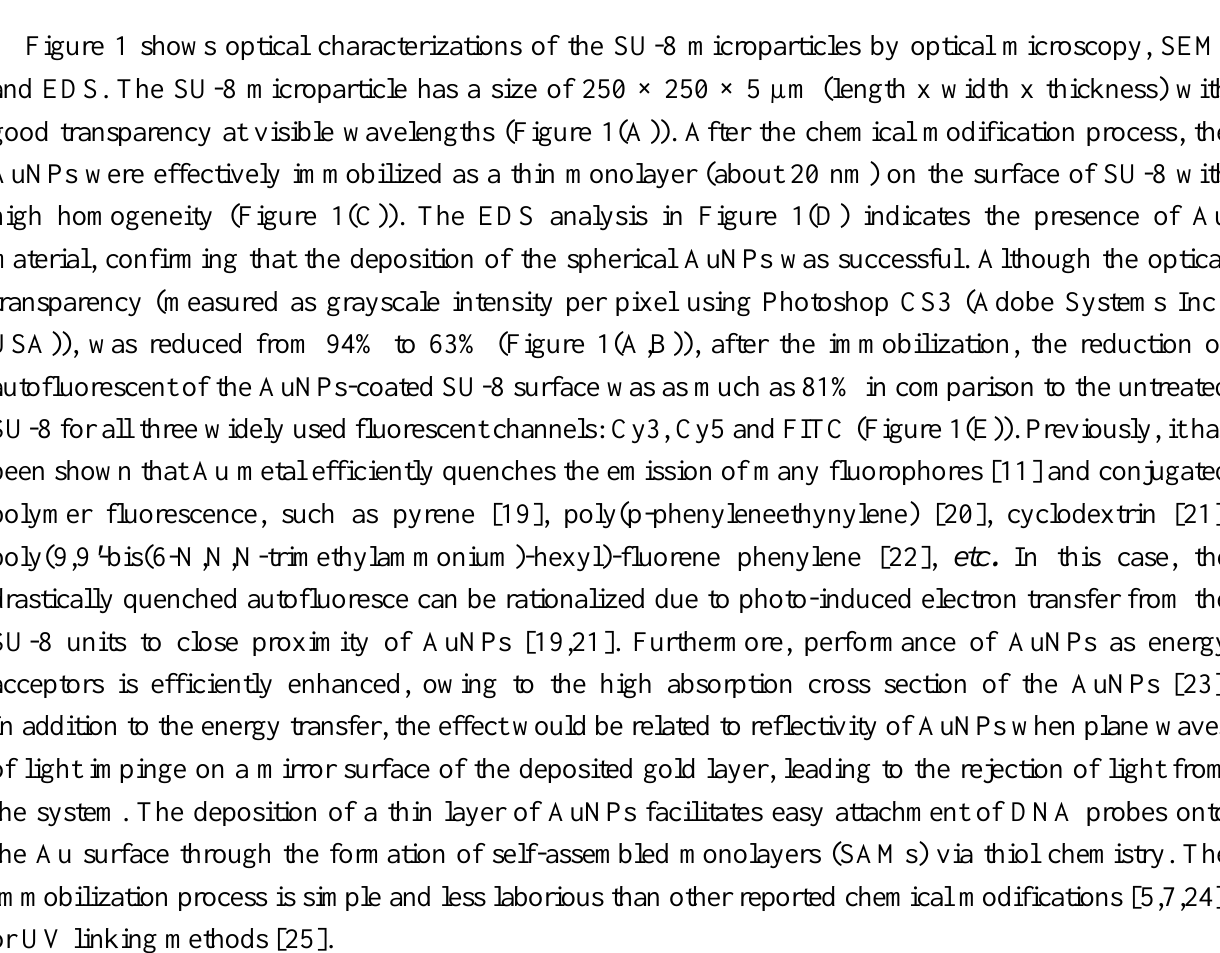
Figure 2. ( A ) Investigation of thermal stability of the immobilized DNA probe. After treatment at different temperatures, the immobilized DNA probe was hybridized with its Cy5-tagged complementary 45-mer sequence and scanned for the fluorescence intensity. ( B ) Sensitivity of a DNA hybridization assay on the Au-coated SU-8